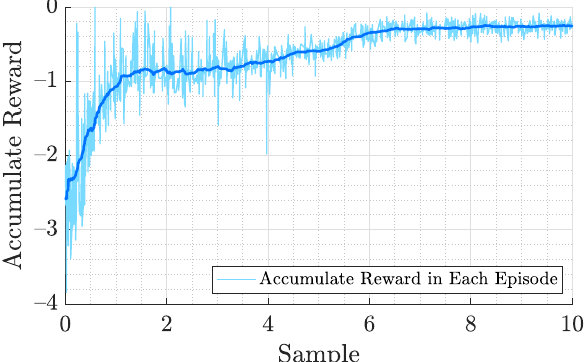
Figure 5. Accumulated reward training curve of each episode in RL controller optimization and is sampled every 100 steps update. The solid line indicates the average value. The training takes approxi- mately 10 million steps to train a control policy that achieves steady hovering at a designated position.